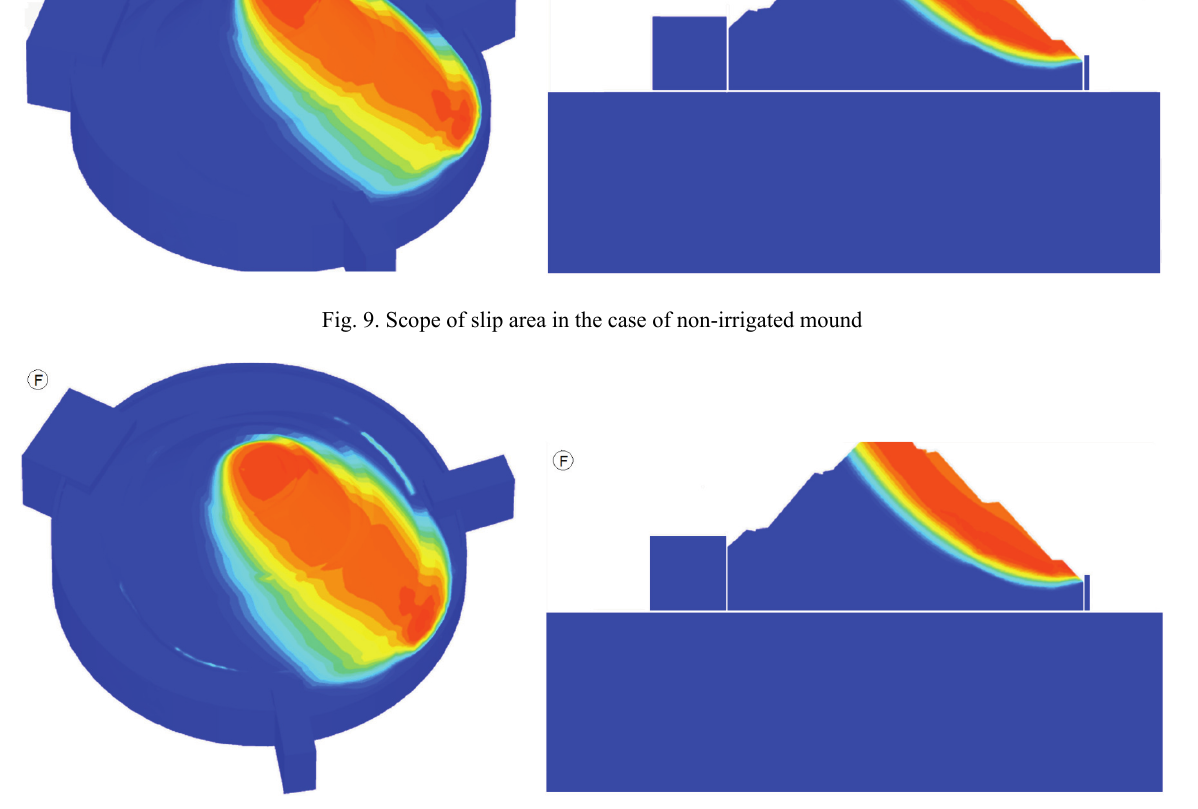
Fig. 10. Scope of slip area in the case of irrigated mound after 33 days of heavy rainfall (similar shape to Fig. 9, see Fig. 11)